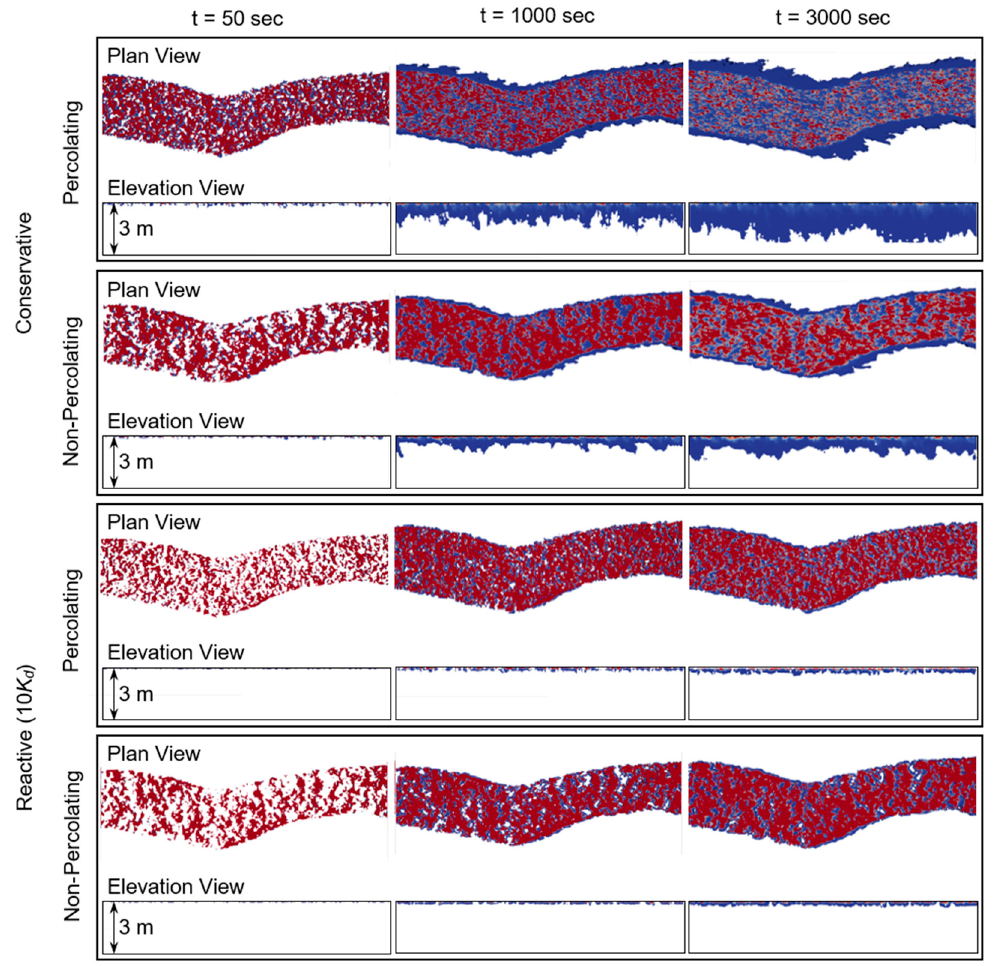
Figure 7. Conservative and reactive solute distributions for percolating and non-percolating heterogeneous sediments. Both a plan view and elevation view are shown. Concentration is normalized to the initial downwelling value, where red indicates high concentrations and blue indicates low concentrations.